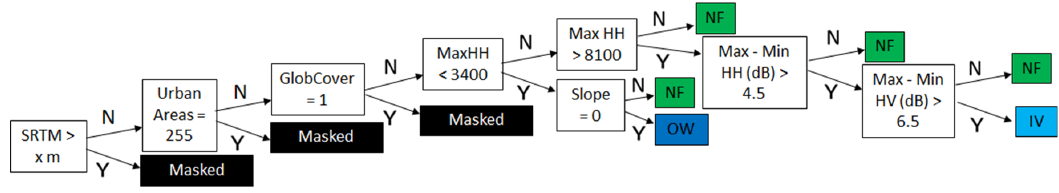
Figure 5. Decision tree for minimum inundation classification. IV: inundated vegetation, OW: open water, NF: non-flooded vegetation.